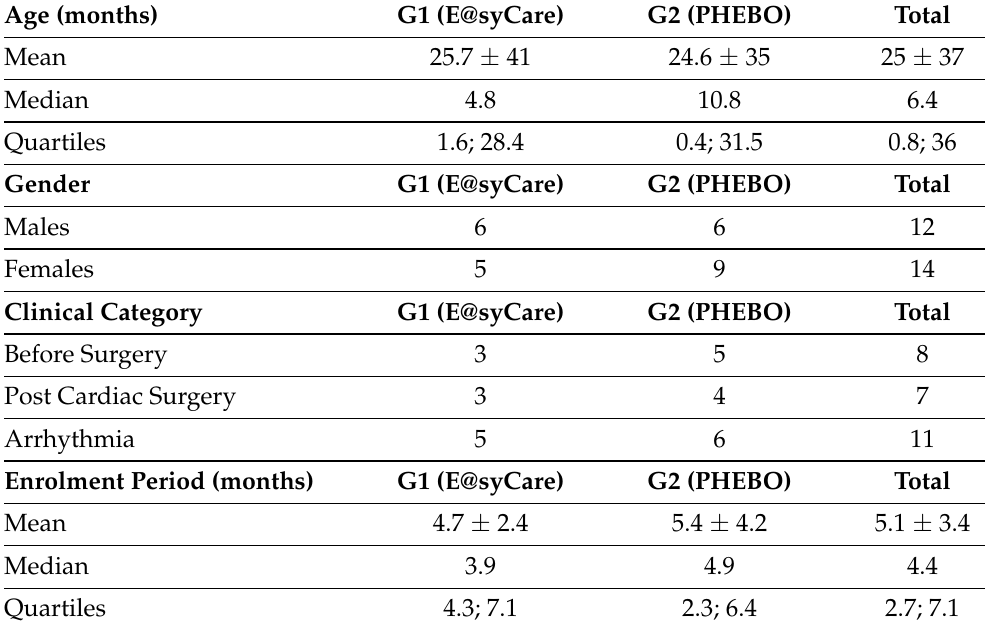
Table 2. Characterisation of the population of the experimental